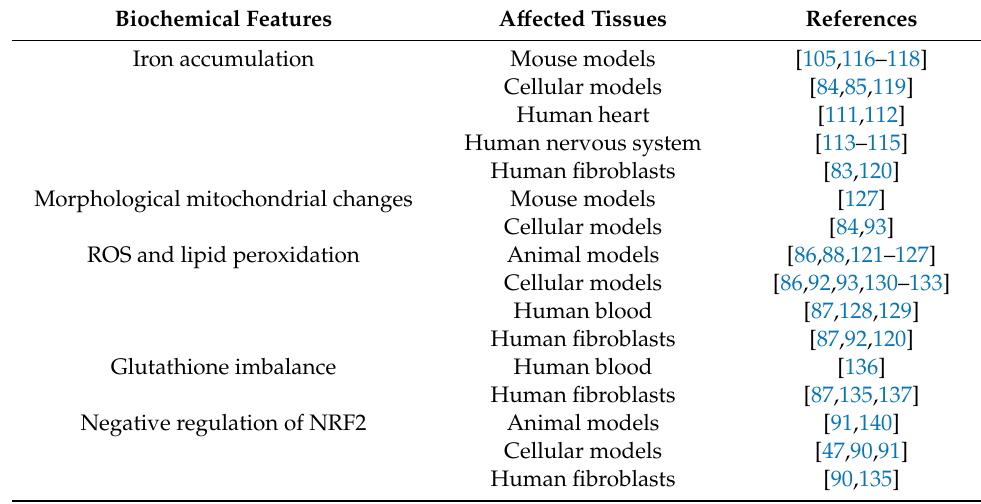
Table 1. Ferroptosis-related phenotypes in Friedreich’s Ataxia